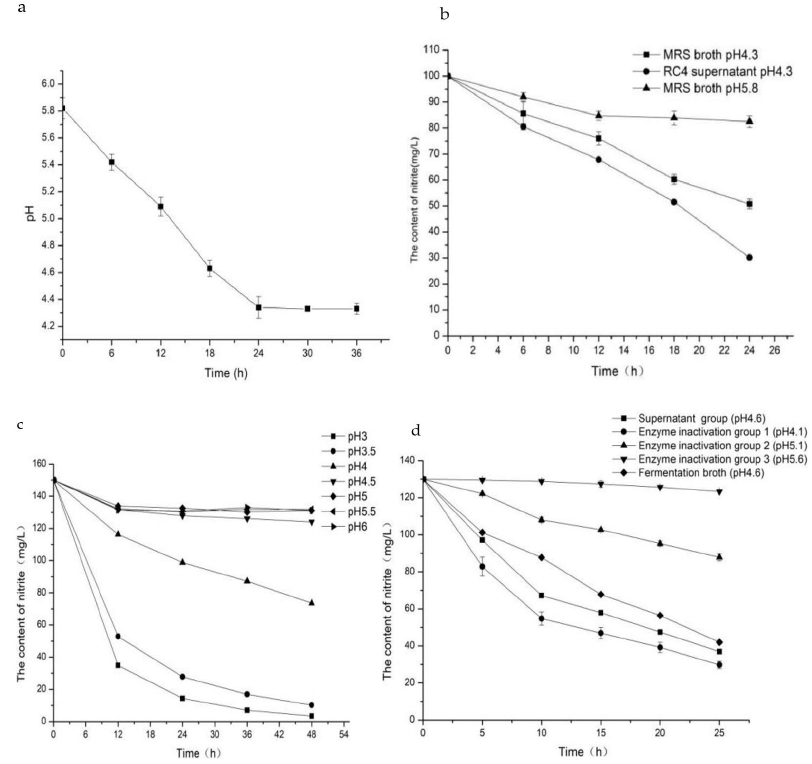
Figure 2. Acid production curves of L. fermentum RC4 ( a ) Nitrite degradation curves of L. fermentum RC4 metabolites and MRS culture broth; ( b ) Nitrite degradation curves in different pH; ( c ) Nitrite degradation curve of L. fermentum RC4 metabolites in synergy with acid ( d ) .